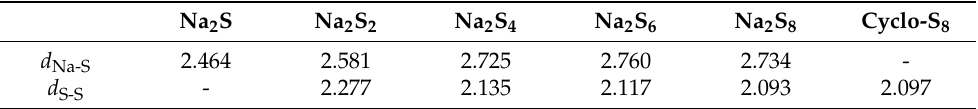
Figure 1. ( a ) The optimized atomic configurations of ( a ) isolated cyclo-S 8 and Na 2 S n (n = 8, 6, 4, 2, and 1) species. ( b ) The top and side views of optimized metal-N 4 @graphene substrate. Table 1. The average bond length ( d ) of isolated Na 2 S n species and cyclo-S 8 . The unit of bond length is angstrom (Å ).